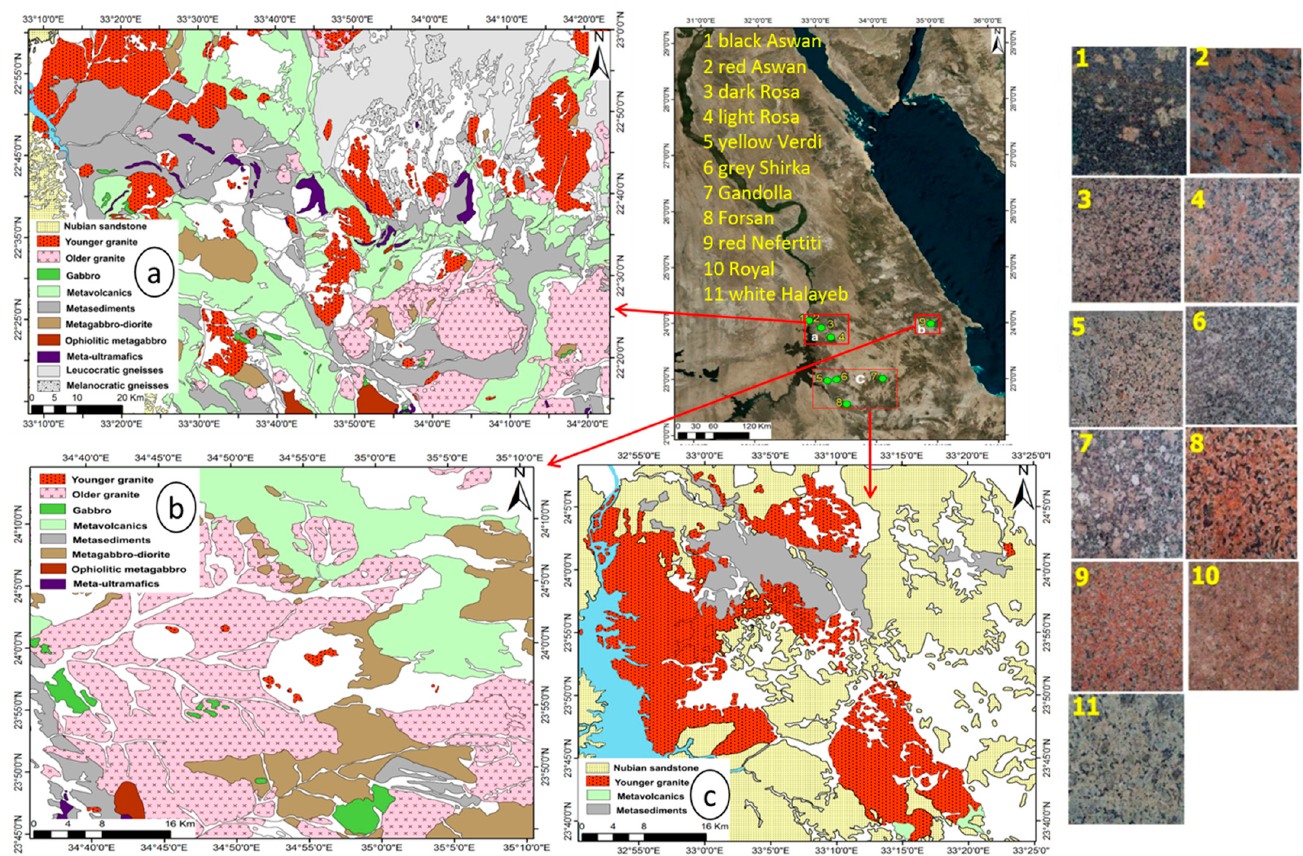
Figure 1. Granite sampling locations over a wide area ( a ) around Aswan city, ( b ) east of Aswan city, and ( c ) south of Aswan city with the appearance of Aswan granites: 1—black Aswan, 2—red Aswan, 3—dark Rosa, 4—light Rosa, 5—yellow Verdi, 6—grey Shirka, 7—Gandolla, 8—Forsan, 9—red Nefertiti, 10—Royal, 11—white Halayeb.